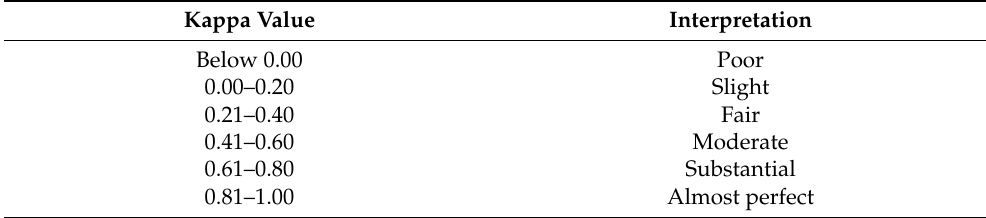
Table 4. Kappa values and interpretation